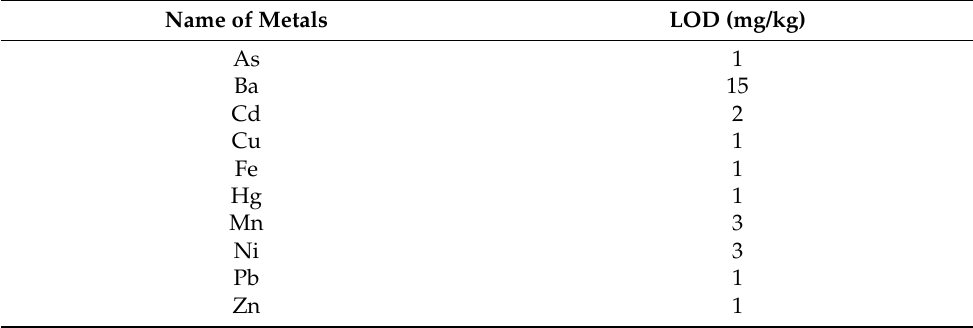
Table 2. Limit of detection (LOD) of Olympus Vanta XRF